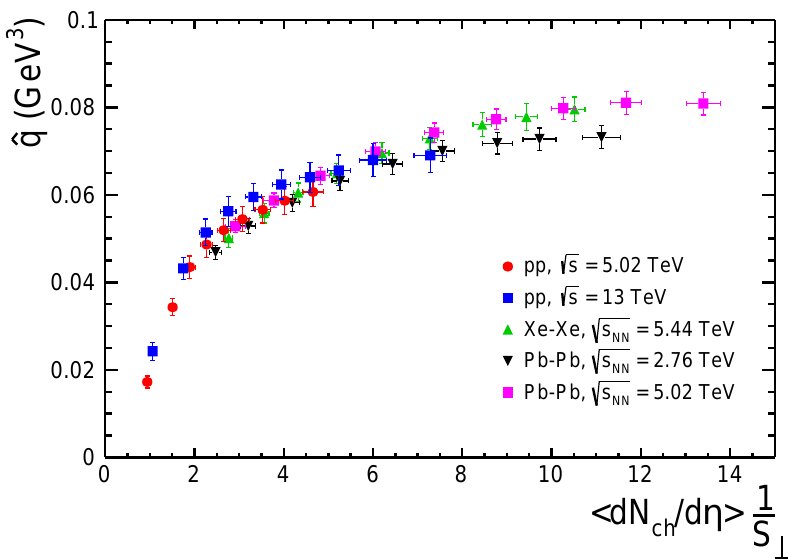
Figure 4. Jet quenching parameter, ˆ q , as a function charged particle multiplicity scaled with transverse overlap area ( S ⊥ ) within the CSPM for pp collisions at √